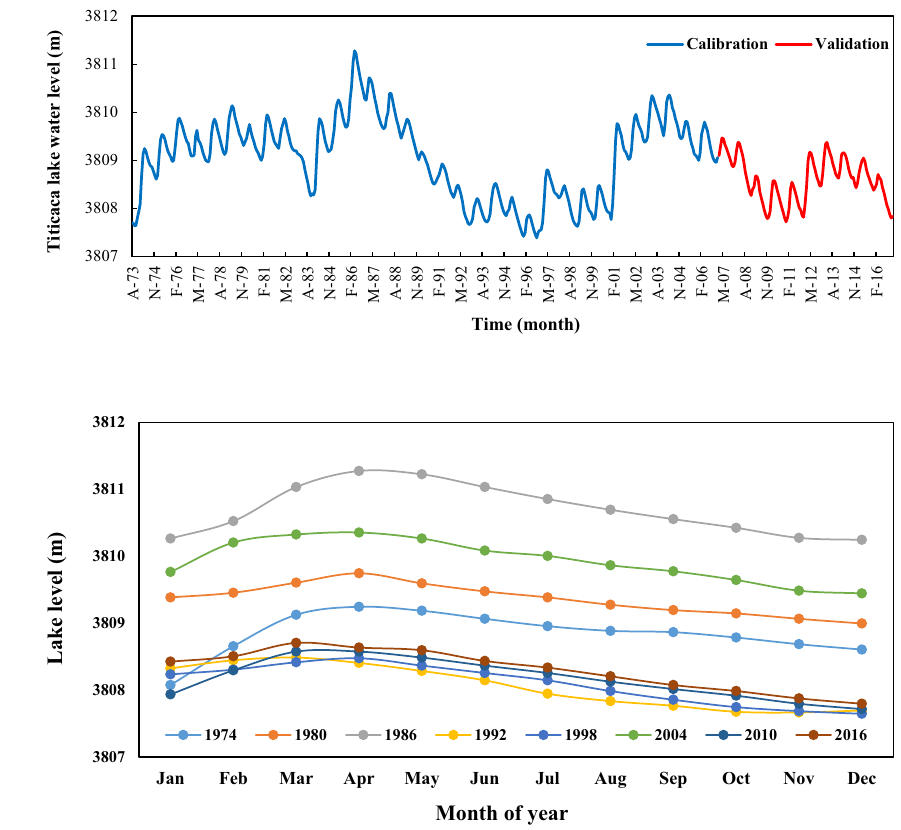
Fig. 2 Titicaca water level in duration study period (1973– 2017)